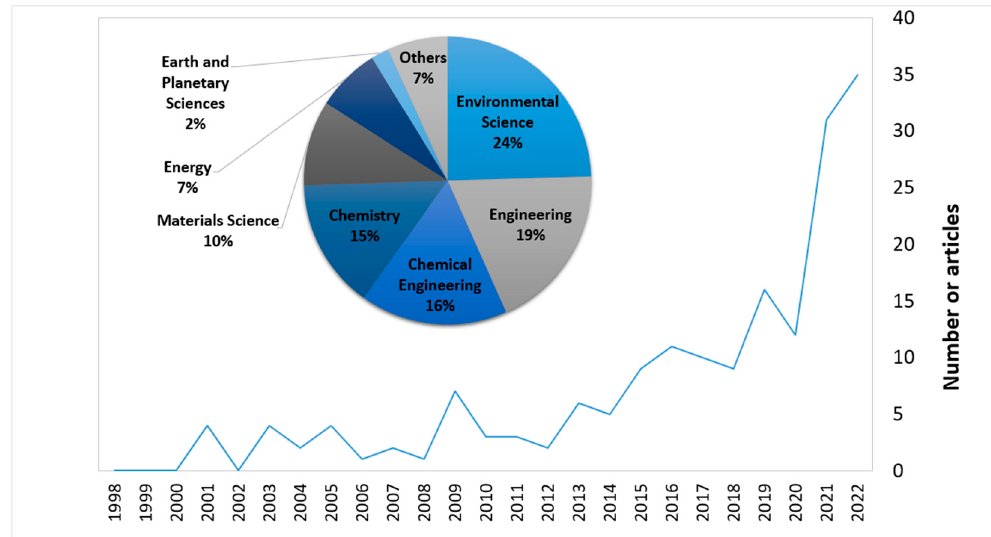
Figure 1. Evolution over the past 25 years of the number of journal articles with topic keywords “brine mining” OR “brine management” OR “brine treatment” OR “brine valorisation” OR “resource recovery” AND desalination in article title, abstract, or keywords.